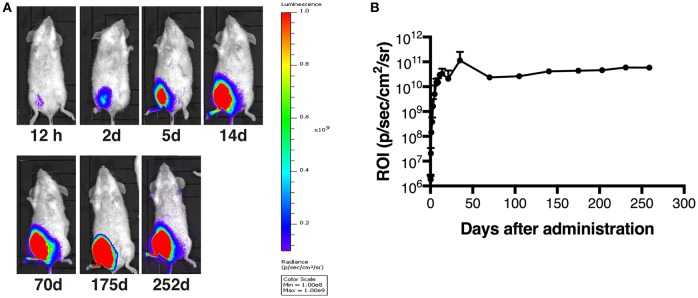
Long-term transgene expression after muscle transduction with AAV1-Luc. (A) Luciferase expression at different timepoints, detected by using the IVIS Lumina LT Series III in vivo imaging system. AAV1-Luc was administered into the right medial thigh muscles of BALB/c mice (n = 3; 1 × 1011 vg/mouse) on day 0. Luciferase expression remained high up to 252 days post-administration of AAV1-Luc. The heat map images visible in the mice represent the total flux of photons (p/s/cm2) in that area. Rainbow scales are expressed in radiance (p/s/cm2/sr). (B) The mean total flux of photons is shown as a region of interest (ROI) from day 0 to day 252 after administration of AAV1-Luc.